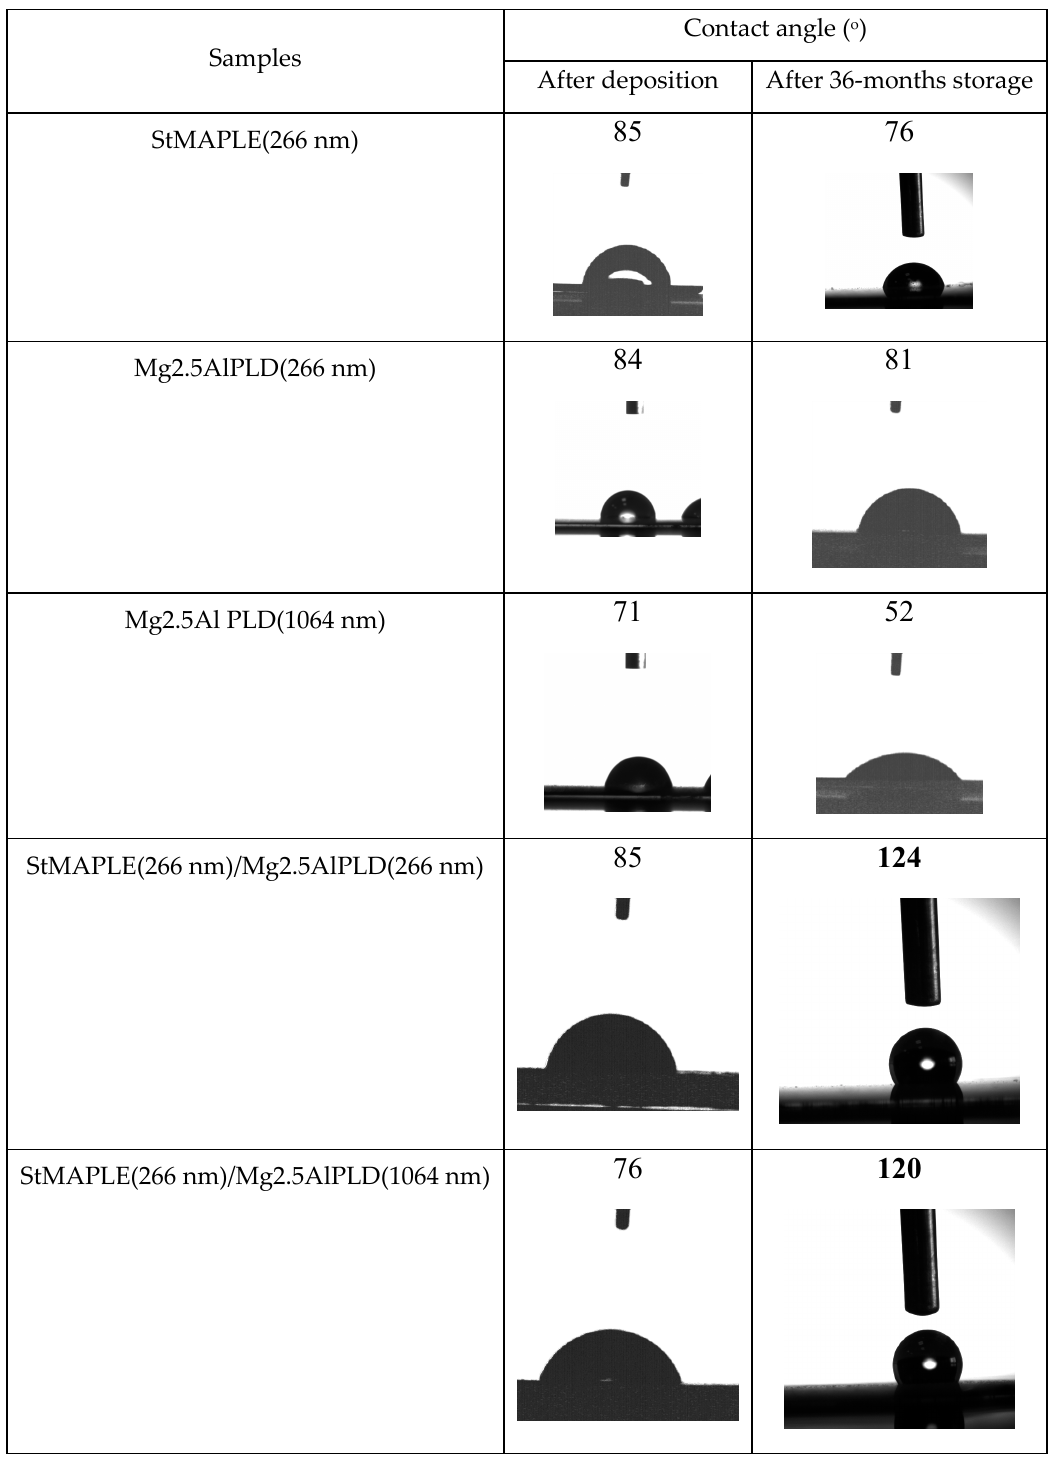
Figure 5. The contact angles values and the photographs of the water droplets on the surface of the as ‐ deposited films.